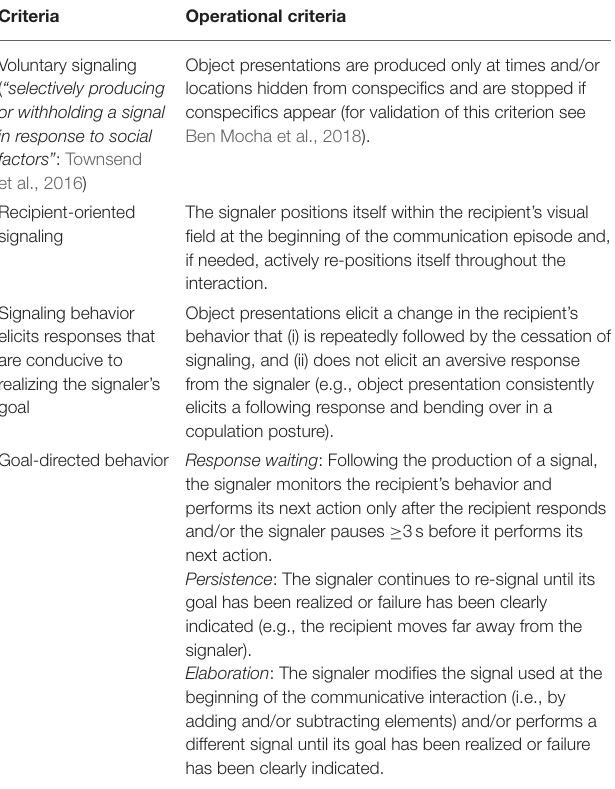
TABLE 2 | Criteria used to infer intentional communication. Criteria